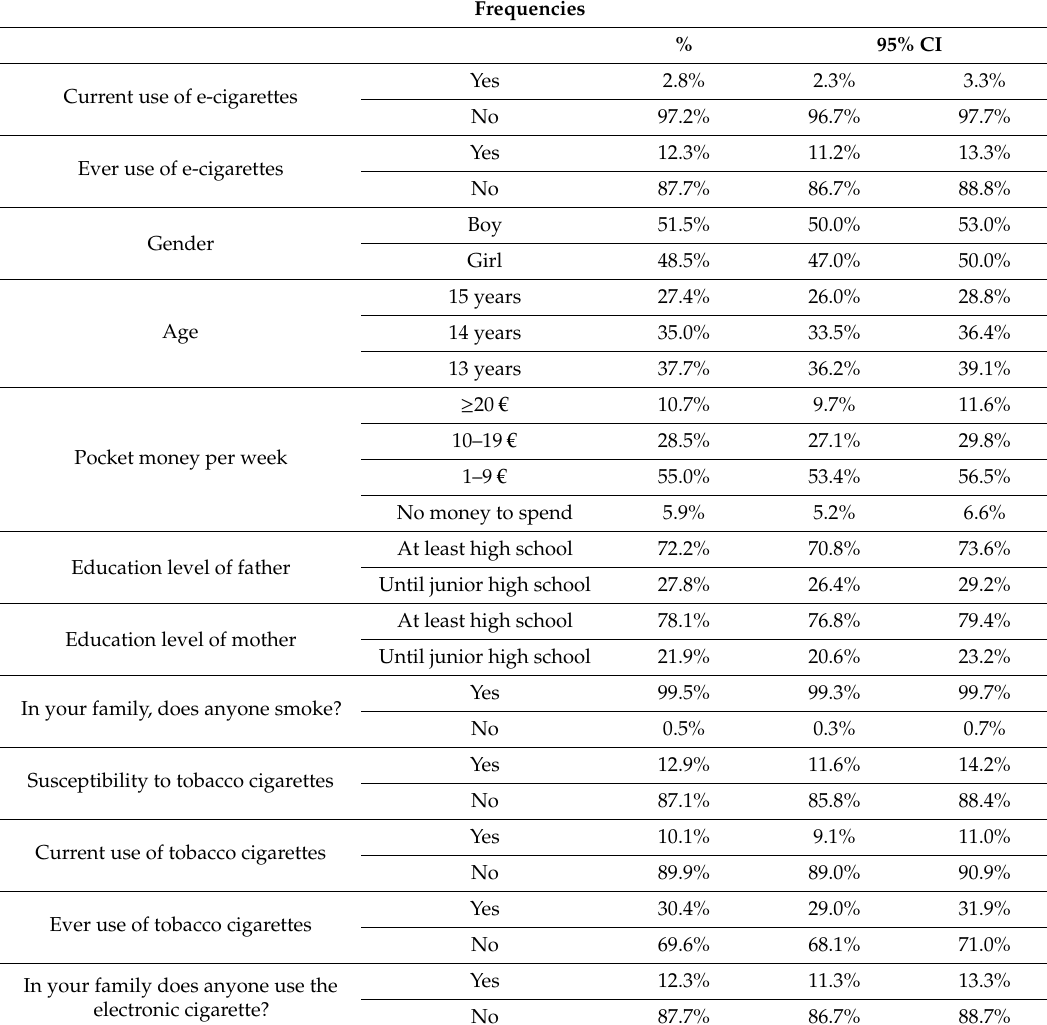
Table 1. Descriptive table of frequencies including all